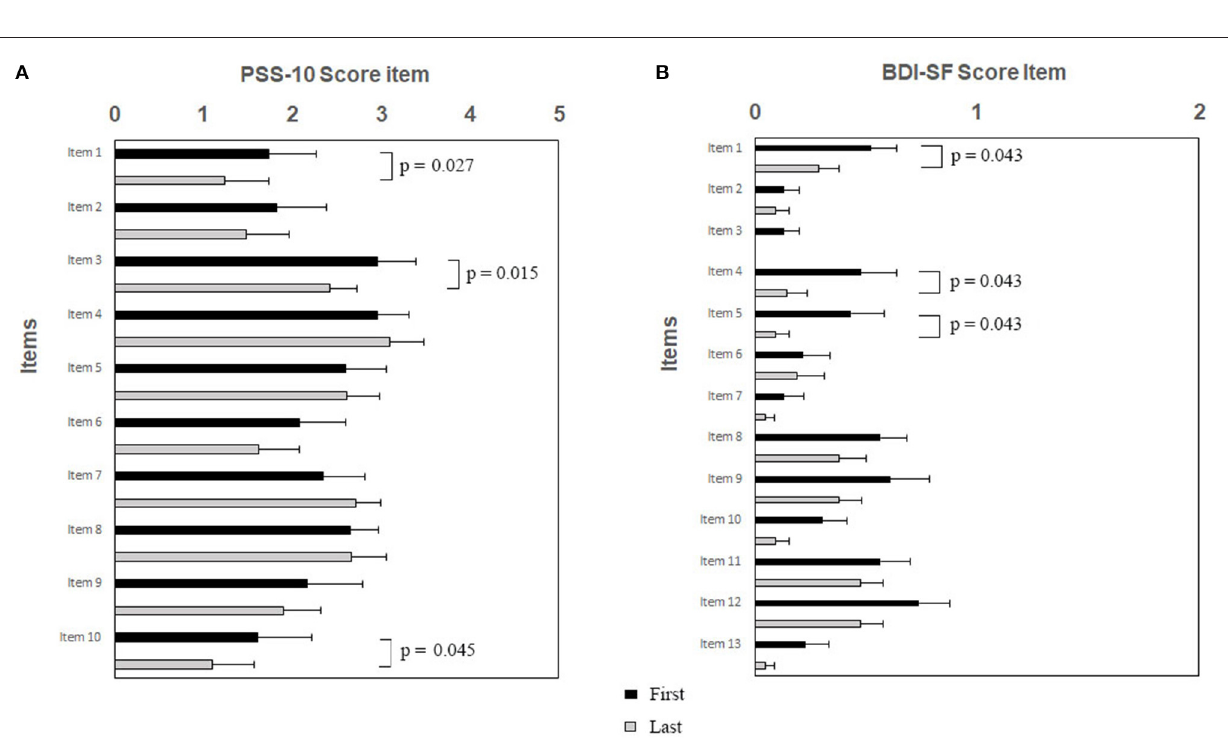
with both neurotrophin levels in saliva in the last session (rho = − 0.50; p = 0.06; rho = − 0.57; p = 0.06, respectively) while BDI-SF total score was clearly correlated with NGF saliva levels in both first and last post sessions (rho = 0.66; p = 0.009; rho =